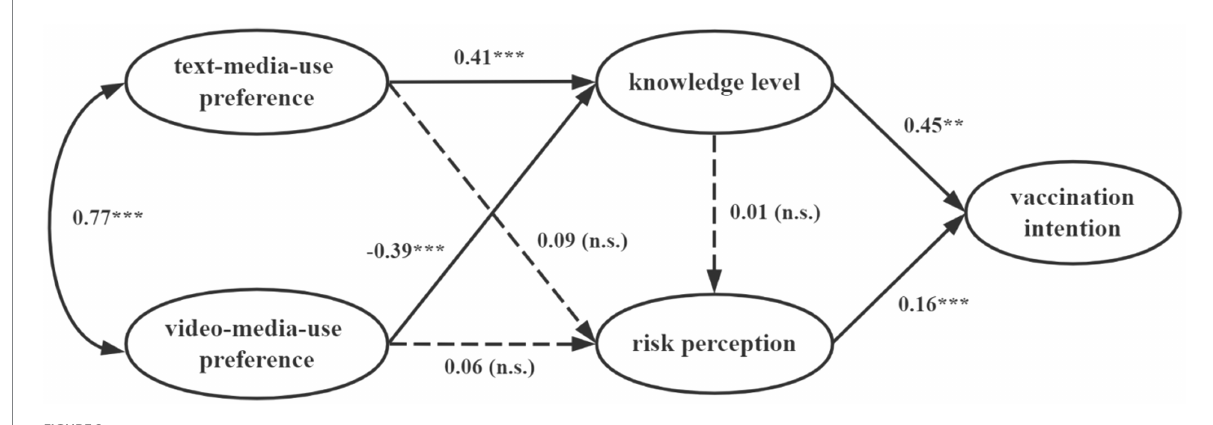
FIGURE 2 Results of the research model. * p < 0.05, ** p < 0.01, *** p < 0.001, n.s.: non-significant at